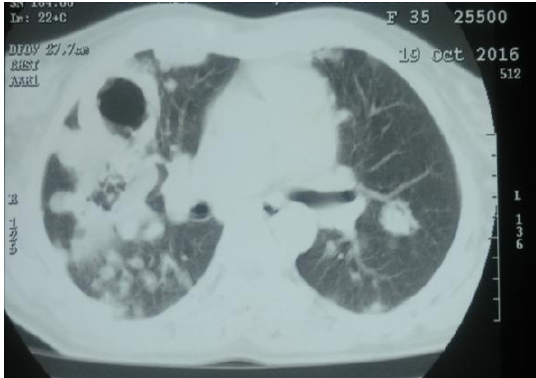
Figure 2 . Computed Tomogram of patient showing nodular opacities of varying sizes in both lobes a few of which cavitate